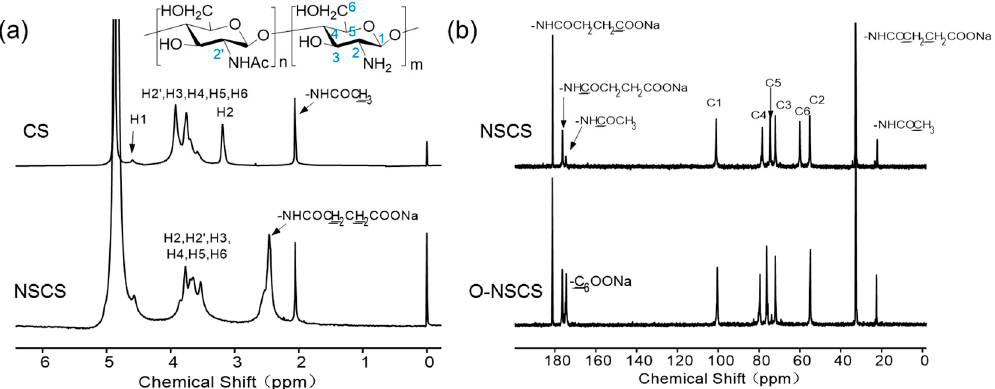
Figure 2. ( a ) The structure of CS and 1 H NMR spectra of CS and NSCS with MS = 0.86 at 298K. ( b ) 13 C NMR spectra of NSCS and O-NSCS with degree of oxidation (DO) = 100%.